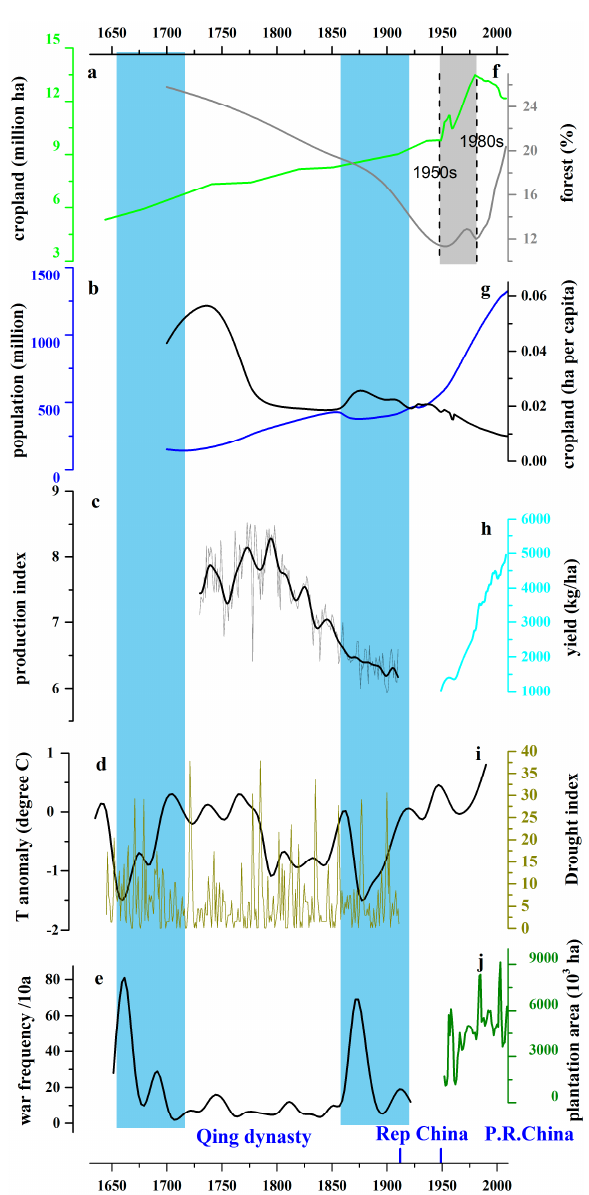
Figure 4. Chinese land-use changes and associating factors during the past 300 years. ( a ): cropland area; ( b ): population; ( c ): production index ( d ): annual average temperature ( e ): decadal war frequency; ( f ): forest coverage rate; ( g ): cropland per capita; ( h ): yield since 1949; ( i ) Drought Index; ( j ) tree plantation area since 1949. The blue shadow sections indicate relatively cold periods, the grey shadow highlights the transition period. This figure was reused from Cui et al., 2015 [49].